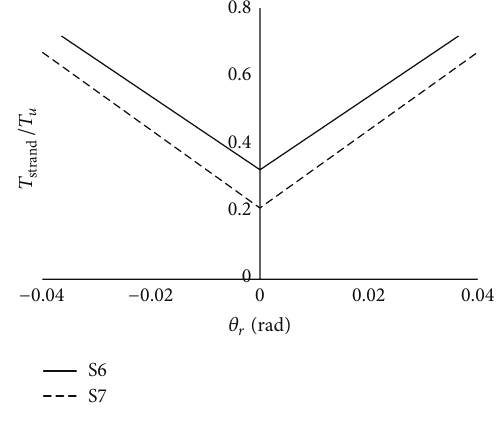
Figure 14: Strand behavior (S6,